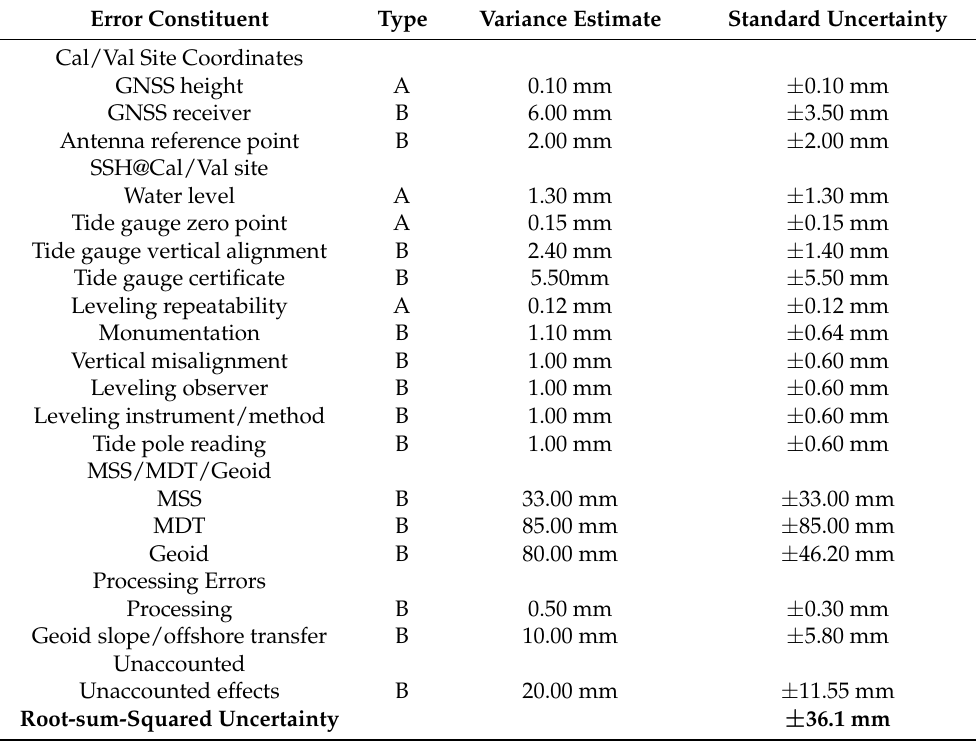
Table 2. Uncertainty budget for the sea-surface calibration following the analysis proposed in the International Standards Organization “Guide to the Expression of Uncertainty in